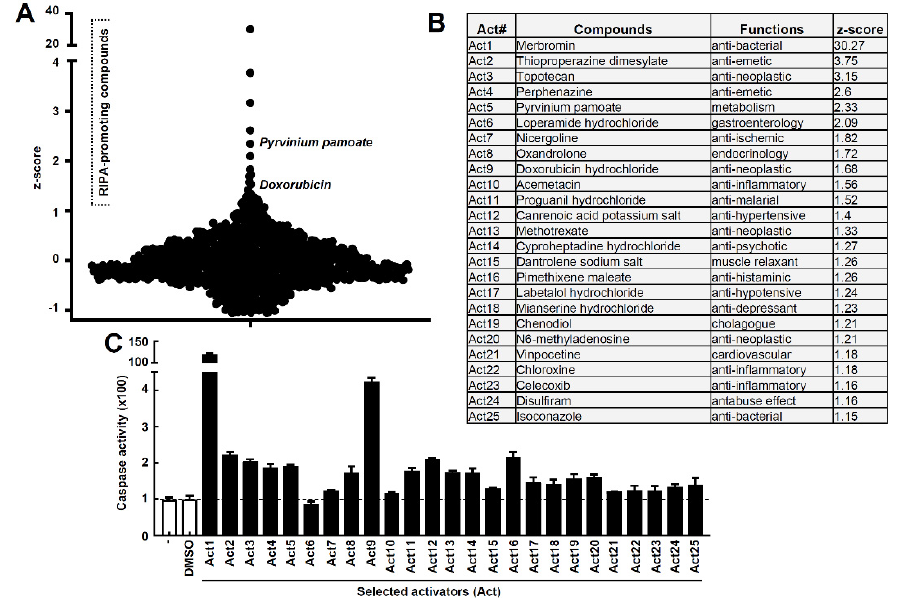
Figure 2. High-throughput screen and validation to isolate RIPA activators. ( A ) Z-scores of the compounds from the primary screen. Caspase activity was normalized to the DMSO control. RIPA-promoting compounds are indicated with z-scores greater than 1. ( B ) Compound names, functions, and corresponding z-scores of the 25 drugs isolated from the primary screen. ( C ) Secondary validation of the primary hits obtained in ( A ). Caspase-3 activity of the selected activators (Act) tested in RLR-stimulated MDA-MB-453 cells normalized to the vehicle (DMSO) control.